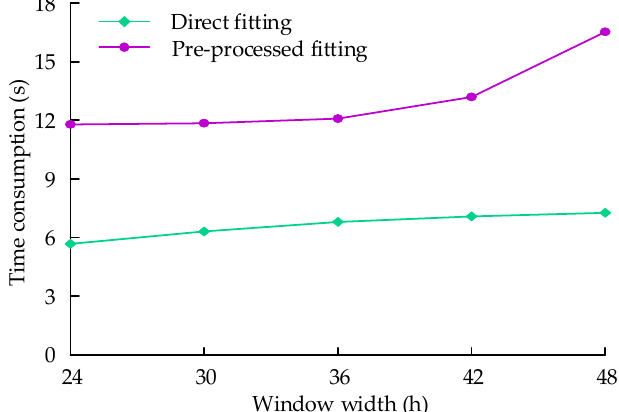
Figure 15. Comparison of the computation durations of di ff erent data processing methods.